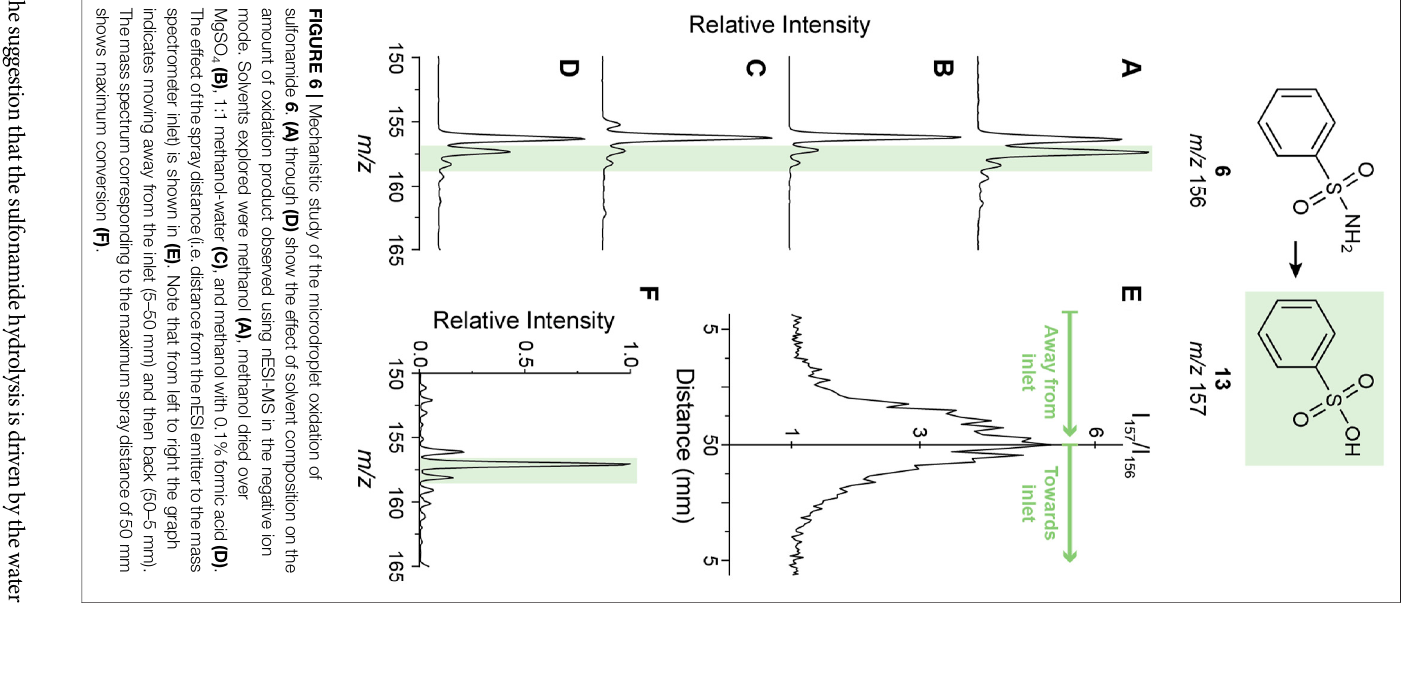
TABLE 1 | Main product ions and neutral losses (in parenthesis) of the [M+18] + _ ions as determined by DESI-MS/MS analysis.* Compound MeOH +0.1% FA MeOH MeOH- d 4 precursor ion: precursor ion: [M+18] + _ precursor ion: [M+18] + _ [M+20] + _ Sulfone 157 ( − 17), 156 ( − 18), 142 ( − 32), 101 ( − 73)*, 96 ( − 78) 157 ( − 17), 156 ( − 18), 142 ( − 32), 101 ( − 73)*, 96 ( − 78) 158 ( − 18), 157 ( − 19)*, 156 ( − 20) Sulfonamide 158 ( − 17), 157 ( − 18), 143 ( − 32)* 158 ( − 17), 157 ( − 18), 143 ( − 32)* 159 ( − 18), 158 ( − 19), 157 ( − 20)*, 142 ( − 35) Ketone 197 ( − 17)*, 196 ( − 18), 182 ( − 32), 179 ( − 35), 161( − 53), 158 ( − 56), 136 ( − 78) 197 ( − 17)*, 196 ( − 18), 182 ( − 32), 179 ( − 35), 161( − 53), 158 ( − 56), 136 ( − 78), 100 ( − 114) 198 ( − 18)* Ester 213 ( − 17), 212 ( − 18), 194 ( − 36), 186 ( − 44)*, 184 ( − 46) 213 ( − 17)*, 212 ( − 18) 214 ( − 18)*, 213 ( − 19), 212 ( − 20) Amide 122 ( − 18)* 122 ( − 18)* 123 ( − 18)*, 122 ( − 19), 121 ( − 20) Carbamate 152 ( − 17)*, 91 ( − 78) 152 ( − 18)*, 91 ( − 78) 153 ( − 18)*, 152 ( − 20), 151 ( − 20), 89 ( − 82) *Three solvent systems were explored, methanol (MeOH) with 0.1% formic acid (FA), pure MeOH, and deuterated methanol (MeOH- d 4 ). For the fi rst two cases the [M+18] + _ ion was selected as precursor ion, whereas for the last one, the [M+20] + _ species was fragmented. The compounds utilized are identi fi ed by their functional groups: sulfone (benzyl methyl sulfone, 5 ), sulfonamide (benzenesulfonamide, 6 ), ketone (2-methylbenzophenone, 7 ), ester (benzyl benzoate, 8 ), amide (benzamide, 9 ), and carbamate (benzyl carbamate, 10 ). The most intense fragment in each MS/MS, spectrum is indicated by